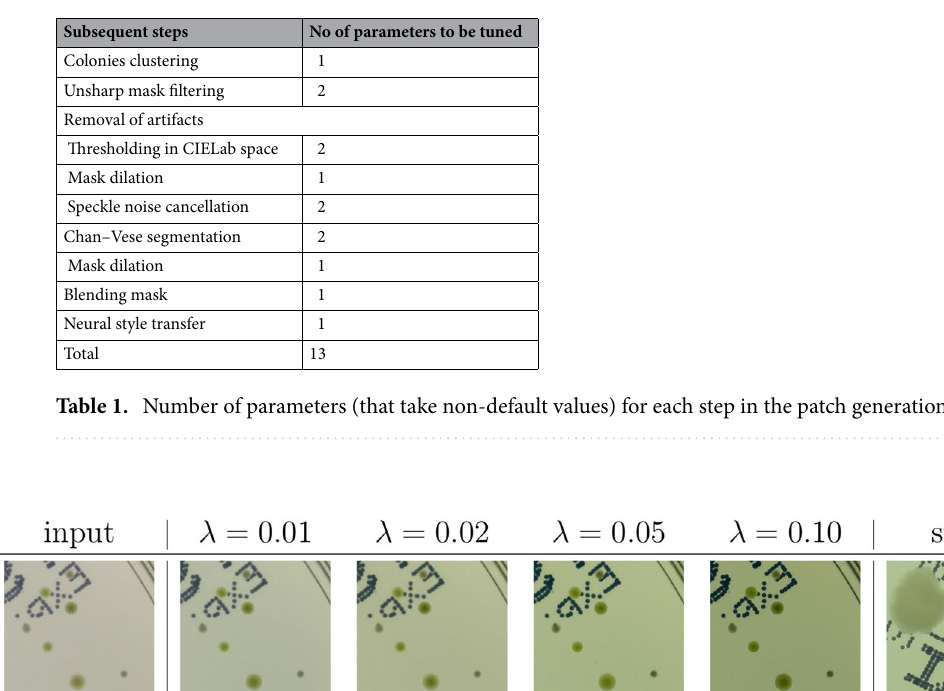
Fig. 4. The image generation network is trained using Stochastic Gradient Descent to minimize L .